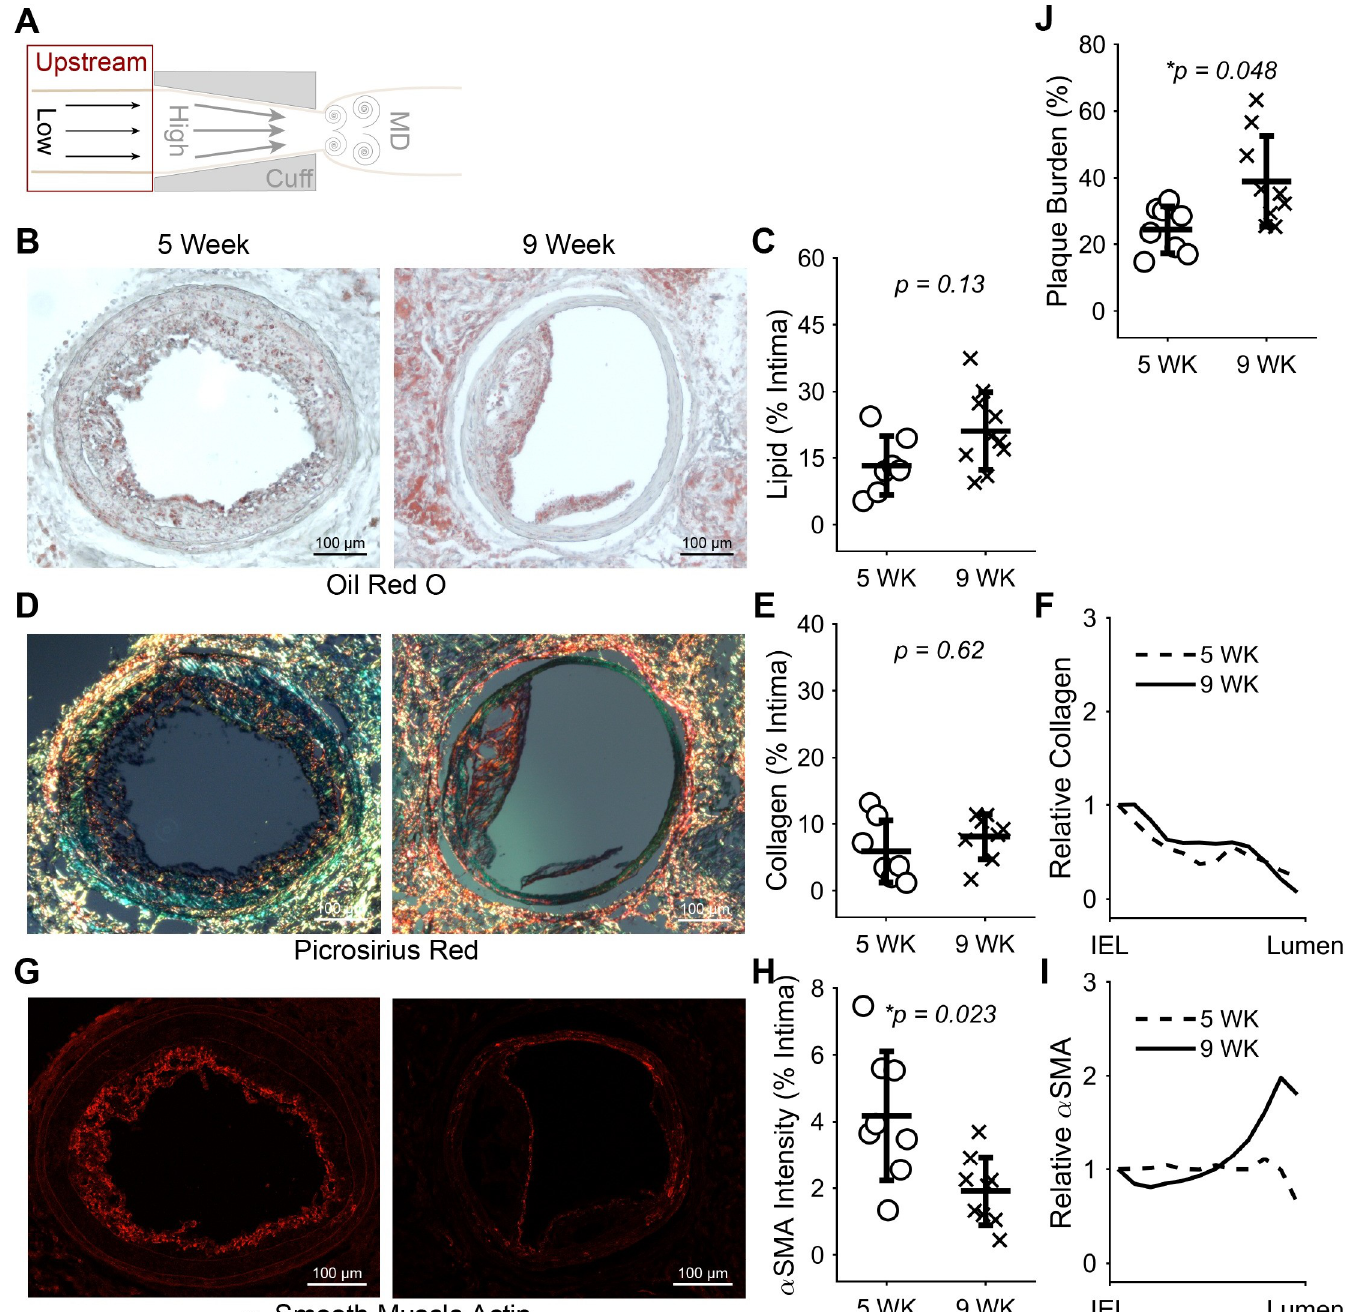
Fig 5. Constituents and size of plaques induced by low WSS at 5 versus 9 weeks. (A) Diagram of the instrumented carotid artery highlighting the focus of this figure on the low WSS (upstream) region. (B) Representative histology sections stained with oil red O to detect lipid and (C) plot of mean lipid area normalized by intima area across all mice at 5 ( n = 7 mice) and 9 ( n = 10) weeks after cuff placement. (D) Representative histology sections stained with picrosirius red to detect collagen, (E) plot of mean collagen area normalized by intima area at 5 ( n = 7) and 9 ( n = 8) weeks, and (F) plot of mean collagen distribution from the IEL to the lumen normalized by the value at the IEL at 5 and 9 weeks. (G) Representative histology sections stained for α -SMA, (H) plot of mean α -SMA intensity normalized by intima area at 5 ( n = 8) and 9 ( n = 10) weeks, and (I) plot of mean α -SMA intensity distribution from the IEL to the lumen normalized by the value at the IEL at 5 and 9 weeks. (J) Plot of mean plaque burden at 5 and 9 weeks. In the scatter plots, each data point represents the average of all viable histological sections for the given stain in the plaque region of the upstream vessel segment of one mouse. Bars are mean ± SD. � P < 0.05 is considered statistically significant.